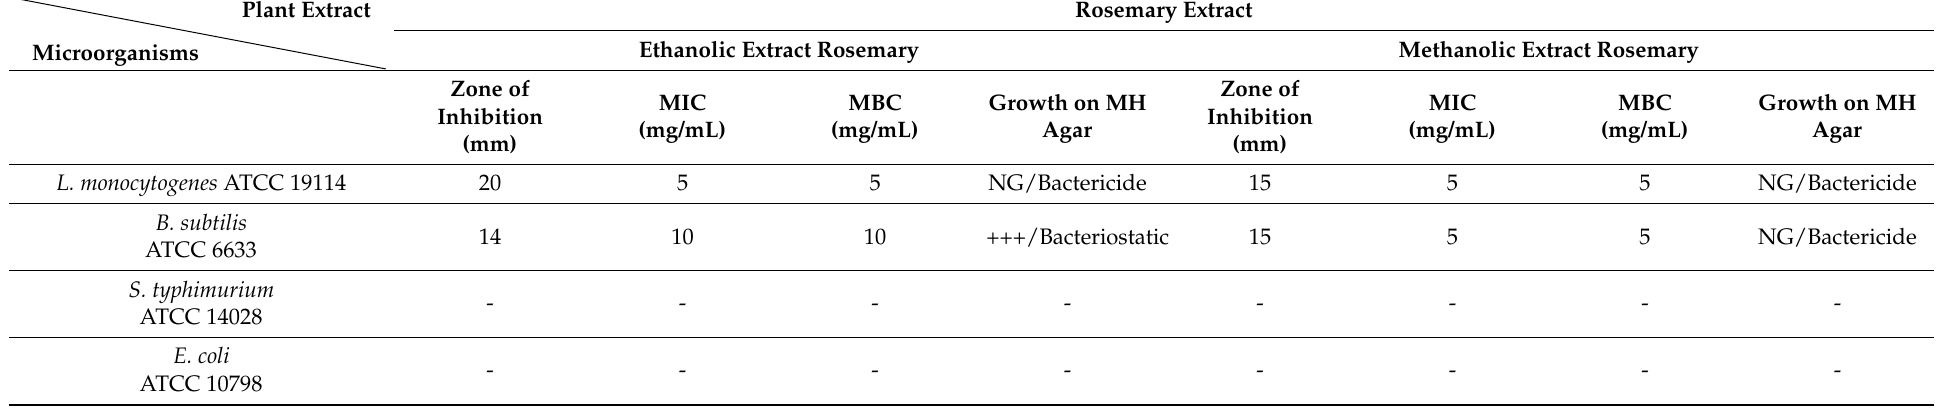
Table 2. Zone of inhibition (mm), MIC and MBC of the of ethanolic and methanolic extracts of rosemary against L. monocytogenes and B. subtilis